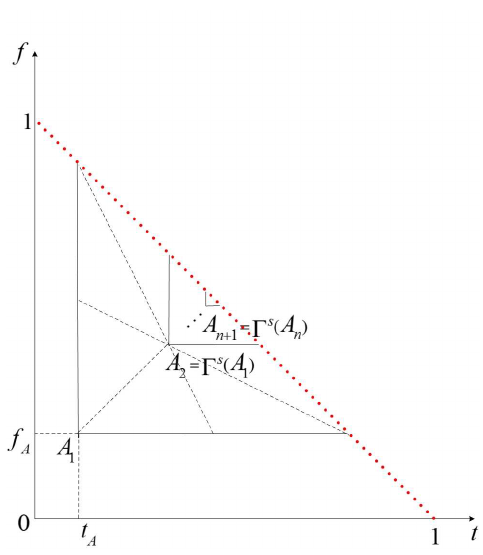
Figure 3. A simple centroid transformation sequence { A n } ∞